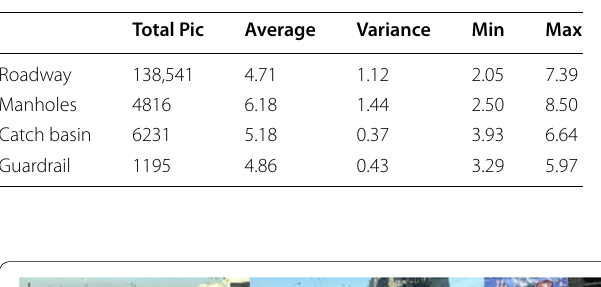
Table 5 Indicators of 4 facility types evaluation